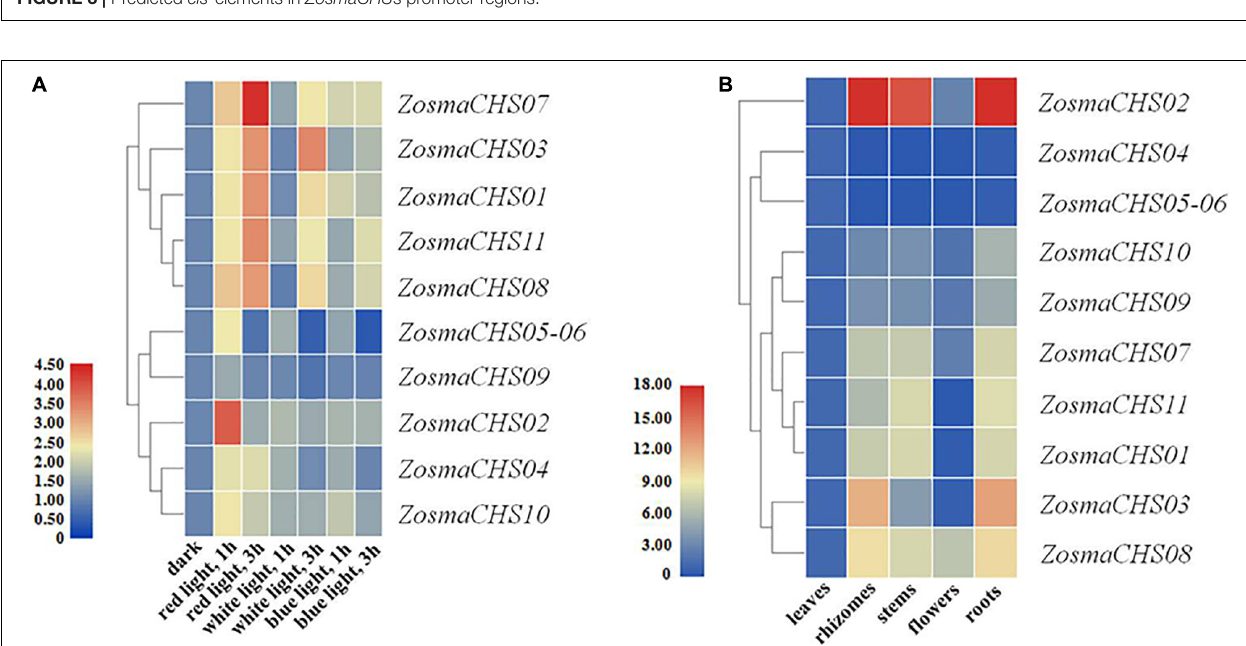
Frontiers in Marine Science |